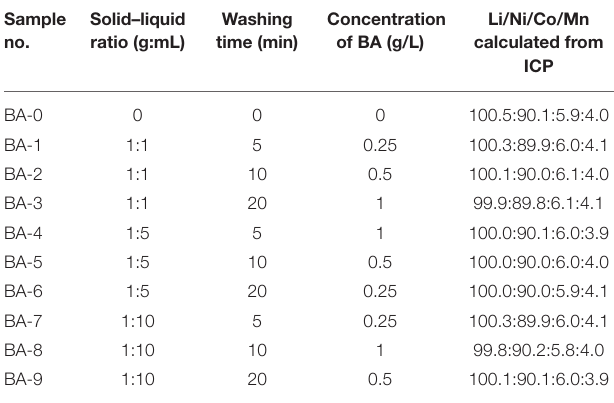
TABLE 1 | Summary of the treat parameters and Li/Ni/Co/Mn molar ratios calculated from ICP-OES of all the samples. Sample